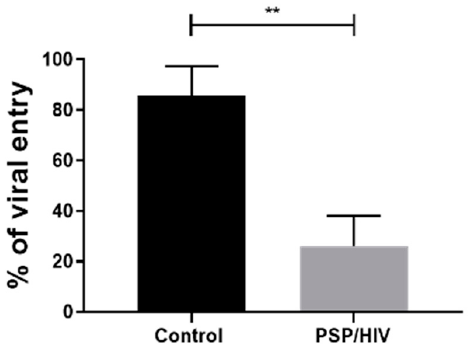
Figure 2. PSP lowers HIV entry in THP1 cells. Percentages of HIV entry in PSP-treated cells analyzed through viral load of HIV p24 antigen and compared with unpaired t test. Data are represented as mean ± SEM. Statistically significant difference (**), p < 0.01 is shown, n = 3. 3.3. Inhibition of PKR and IRE1 α Are Associated with an Increase in HIV-1 Entry Our data indicate that PSP has the potential to restrict HIV-1 entry as well as to induce the di ff erential regulation of cytoskeletal and UPR proteins. To further investigate the signaling complex that in fl uences this restrictive pa tt ern, the potential roles of PKR and the UPR marker IRE1 α in HIV-1 entry were studied by subjecting THP1 cells to C16- PKR and 4µ8C-IRE1 α pharmaceutical inhibitors. We hypothesized that inhibition of either the activation of PKR or the endoribonuclease activity of IRE1 α would a ff ect viral entry into host immune cells. This is based on the overlapping signaling complex with downstream cytoskeletal e ff ectors as seen in the literature research. Therefore, THP1 cells were treated twice with either 56.09 nM of C16 or 221.8 nM of 4µ8C for a period of 5 h prior to PSP treatment and HIV-1 infection. DMSO 0.5% was used as a vehicle control for both blockers. Viral load analysis has revealed no statistical di ff erence in HIV-1 entry for C16, with approximately 89.13% relative to 94.1% for the infected control and 93.96% for the DMSO vehicle group (Figure 3). This correlates to a restrictive percentage of 10.87% for C16-treated PSP-induced cells. Compared to Figure 2, there was a relative increase in viral entry by approximately 63.13% in di ff erence. Moreover, 4µ8C-treated PSP-induced cells showed approximately 69.56% of viral entry (24% restriction relative to the control and vehicle groups). The e ff ects of 4µ8C can be translated to a 19.57% di ff erence in comparison to the C16 blocker, contributing to a signi fi cant reduction in viral access (Figure 3). Taking into consideration the data in Figure 2, the inhibition of IRE1 α endoribonuclease activity represents an approximate increment di ff erence of 43.56% in viral entry. The results for both drugs show an inversely proportional HIV-1 entry and restriction taking place compared to Figure 2.